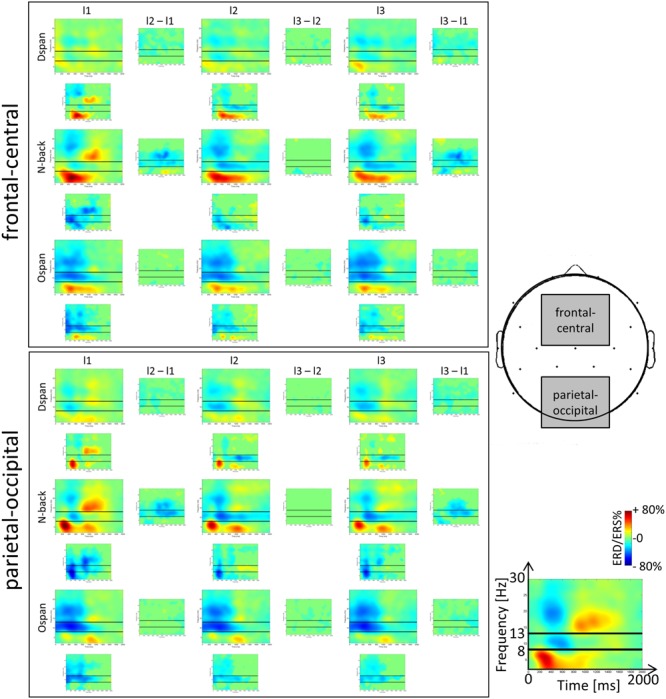
Time-frequency representations (TFRs) of the ERD/ERS%-values of the N-back, Ospan and Dspan task in a frequency range from 2 to 32 Hz and a time range from 0 to 2000 ms post-stimulus onset at frontal-central (Fc1, Fc2, Fz, Cz) and parietal-occipital (P3, P4, Pz, O1, O2) ROIs. From left to right increasing WM-load levels (low, medium, and high). The black horizontal lines in the single TFR-plots denote the lower and upper border of the traditional alpha frequency band (i.e., 8 and 13 Hz). Blue colors signal event-related desynchronization (ERD), red colors signal event-related synchronization (ERS) measured in percent with respect to a baseline condition (see Section “Data Preprocessing and Analysis” for a more detailed description of the calculation of the TFR-plots). The small plots in between the larger TFRs indicate statistically significant differences in ERD/ERS%-values between two adjacent load levels (columns) and tasks (rows). Green color indicates statistically non-significant data points, blue and red colors indicate statistically significant ERD/ERS%-values between adjacent TFR-plots (p < 0.05).